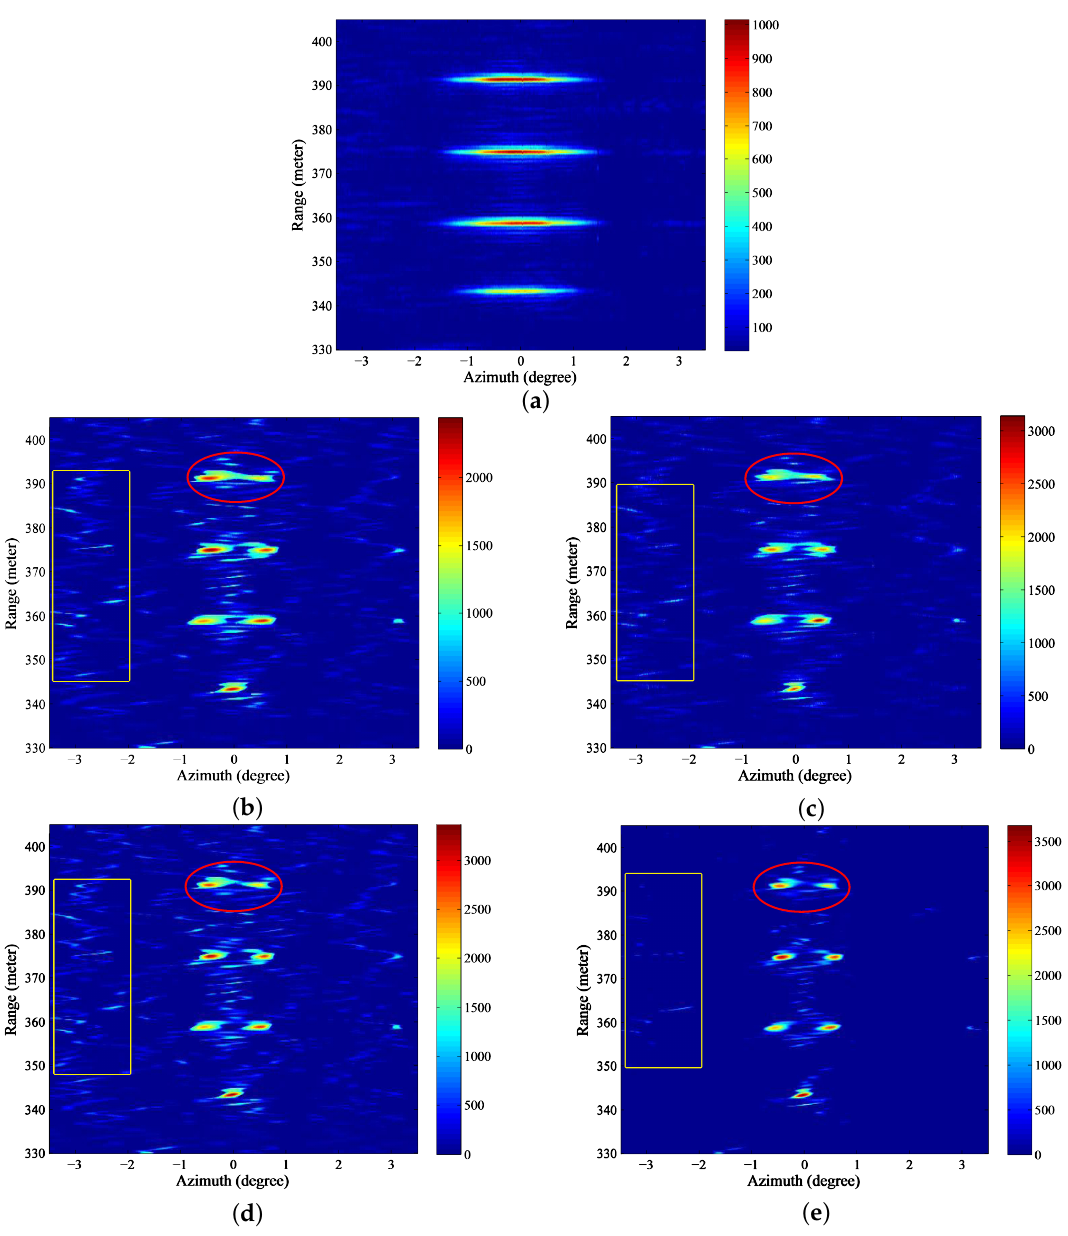
Figure 11. Angular super-resolution results for real beam data through automatically stopping the iterations ( a ) real beam echo after range compression and migration correction, results of ( b ) Landweber ( c ) Richardson-Lucy (RL) ( d ) maximum a posterior (MAP) ( e ) proposed penalized maximum likelihood